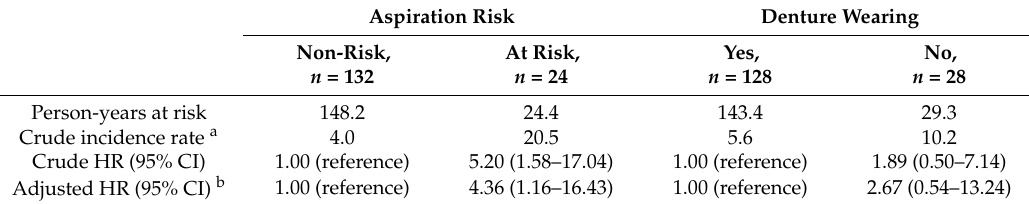
Figure 1. Kaplan–Meier curves showing cumulative incidence of pneumonia according to ( A ) aspiration risk and ( B ) denture wearing. Table 2. Development of pneumonia according to aspiration risk and denture wearing.